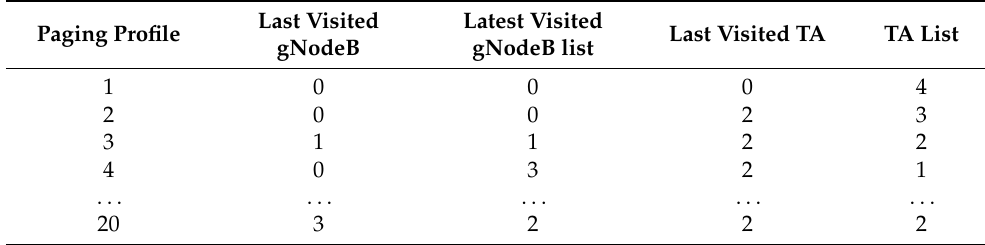
Figure 4. Example of paging on latest gNodeB list. 3. Proposed Machine Learning-Based Paging 3.1. K-Nearest Neighbor (KNN) KNN is a method that determines the category of a new data point by selecting the K closest points from the training data and classifying the new data into one of the cate- gories [11–13]. The KNN uses the Euclidean distance to measure the distance to the target point [14]. If the value of K is small, then the classification becomes sensitive to noise and over- fitting occurs. Conversely, if the value of K is large, then underfitting occurs and compu- tation becomes expensive. Therefore, the K value should be selected appropriately based on the amount of data and the number of classes to be classified.